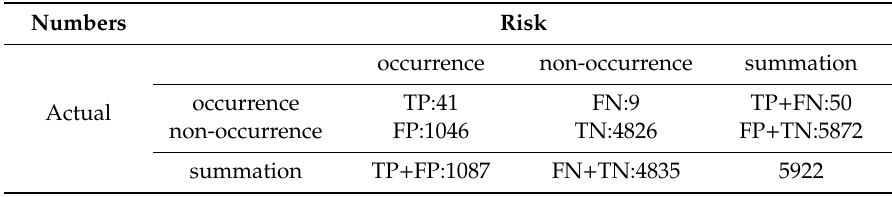
Figure 8. The receiver operating characteristic (ROC) curve of the risk results. Table 2. The True Positives, True Negatives, False Positives, and False Negatives numbers of “best threshold” point.